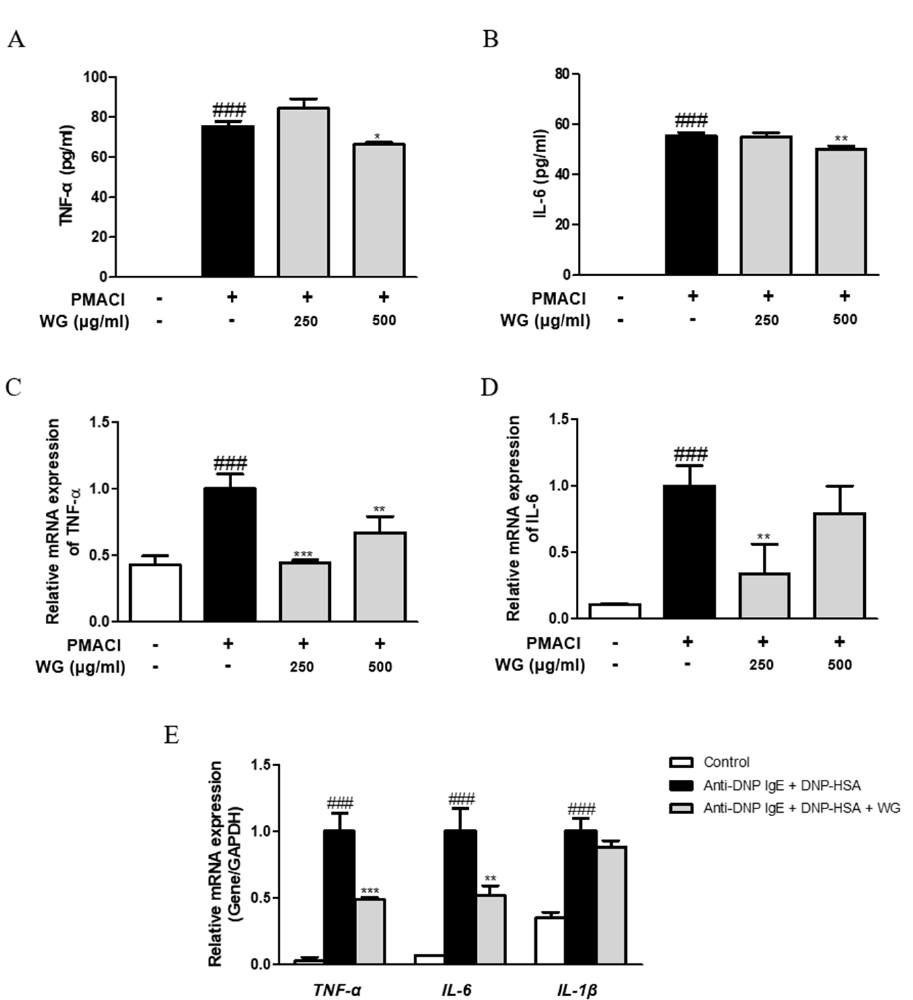
Figure 4. Effects of WG on the proinflammatory cytokines in PMACI ‐ stimulated HMC ‐ 1 and RBL ‐ 2H3 cells. ( A , B ) TNF ‐α and IL ‐ 6 cytokines production was measured using ELISA kit. The mRNA levels of ( C ) TNF ‐α and ( D ) IL ‐ 6 were determined by quantitative qRT ‐ PCR from HMC ‐ 1 cells and ( E ) RBL ‐ 2H3 cells. The data shown represent means ± S.D. of three independent experiments. Note: ### p < 0.001 vs. the control group; * p < 0.05, ** p < 0.01, and *** p < 0.001 vs. stimulator ‐ treated